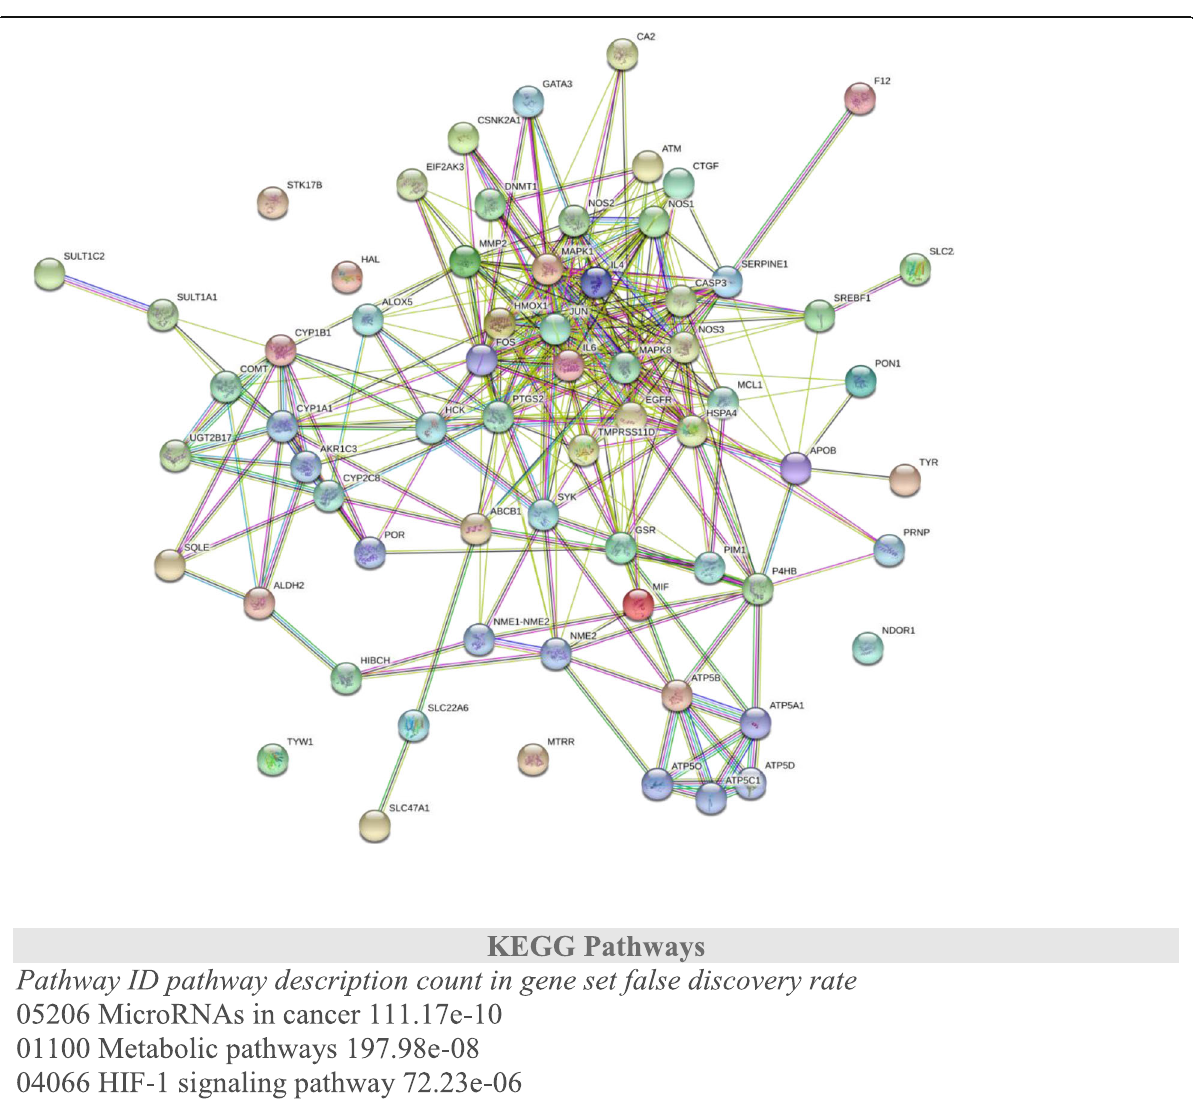
Fig. 7 Network and enrichment analysis showing results obtained upon entering a set of 61 proteins suspected to be involved in Amyotrophic Lateral Sclerosis (55). In the bottom inset, one enriched function has been selected, and the corresponding protein nodes in the network are automatically highlighted in